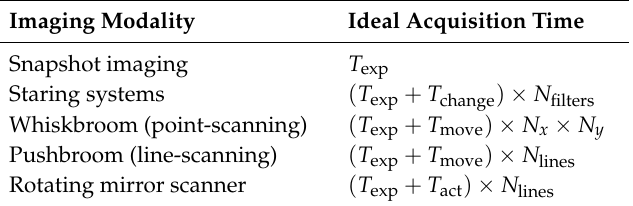
T exp : = exposure time (in s), N filters : = number of filters, N x , N y : = number of spatial positions in the point-scanner,